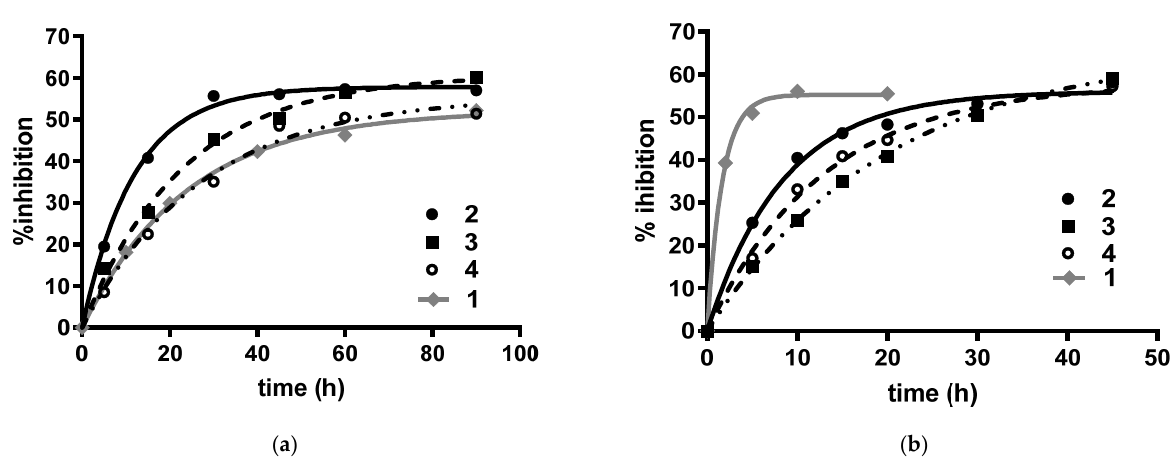
Figure 2 . Time-dependent inhibition of ( a ) hAChE and ( b ) hBuChE by carbamates 2–4 (black lines) and lead compound 1 (grey line) at their IC 50 concentrations.